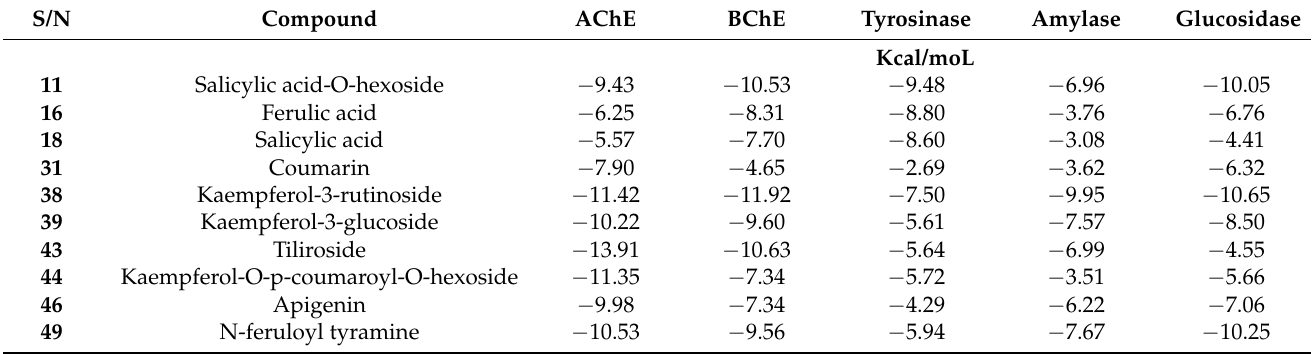
Table 5. Calculated binding affinity of bioactive constituents from secondary metabolites in Alcea fasciculiflora